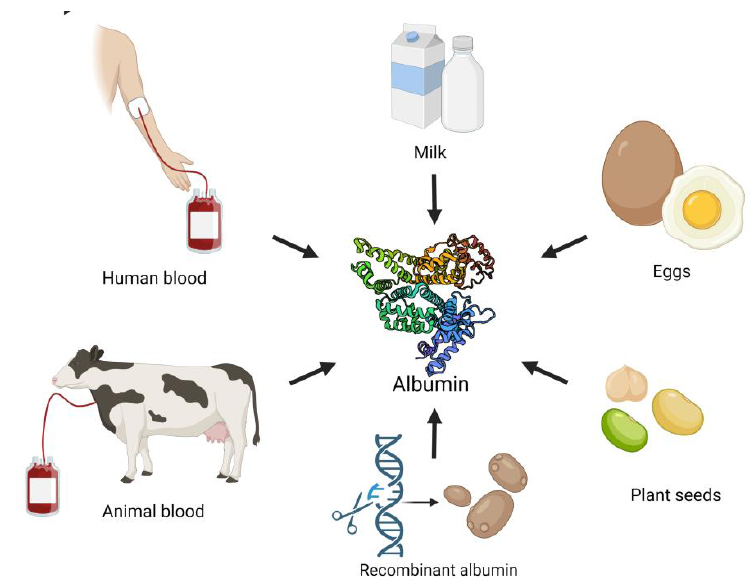
Figure 1. Albumin origin. Created with BioRender.com accessed on 21 August 2022. Table 1. Different albumin types and their characteristics.